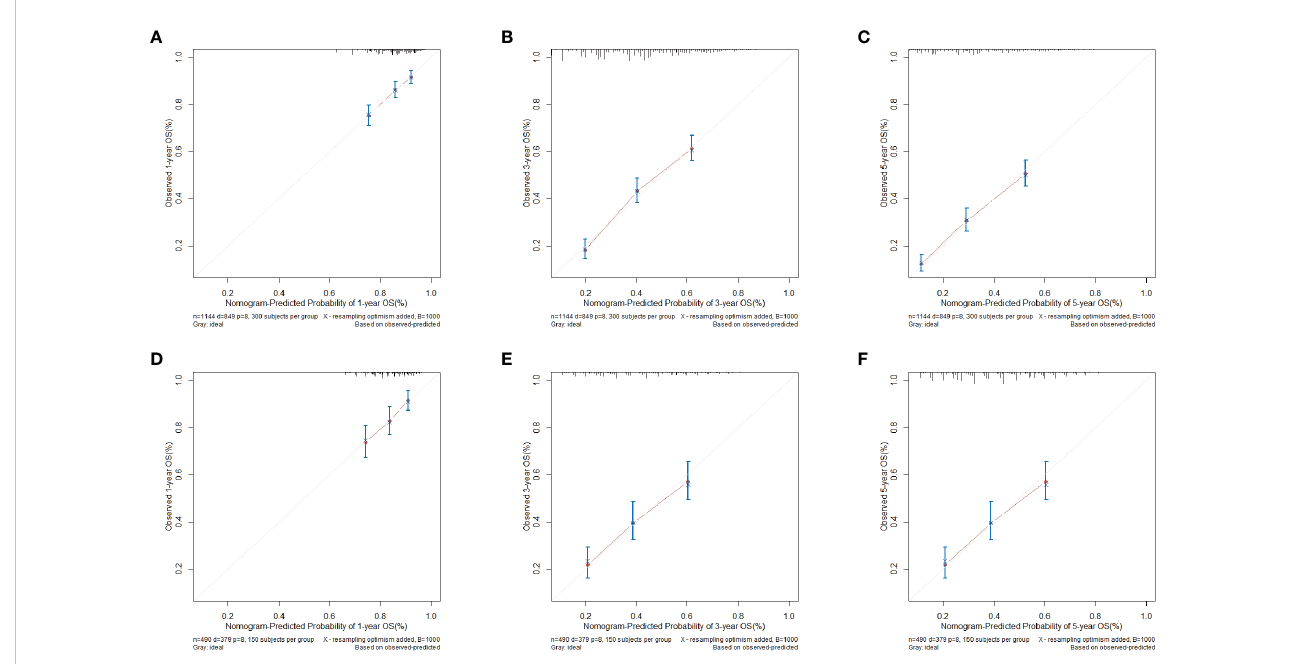
FIGURE 4 Calibration curves for clinical-pathological nomogram model in validation and training cohort. (A) 1-year calibration curve in training cohort. (B) 3-year calibration curve in the training cohort. (C) 5-year calibration curve in the training cohort. (D) 1-year calibration curve in the validation cohort. (E) 3-year calibration curve in the validation cohort. (F) 5-year calibration curve in the validation